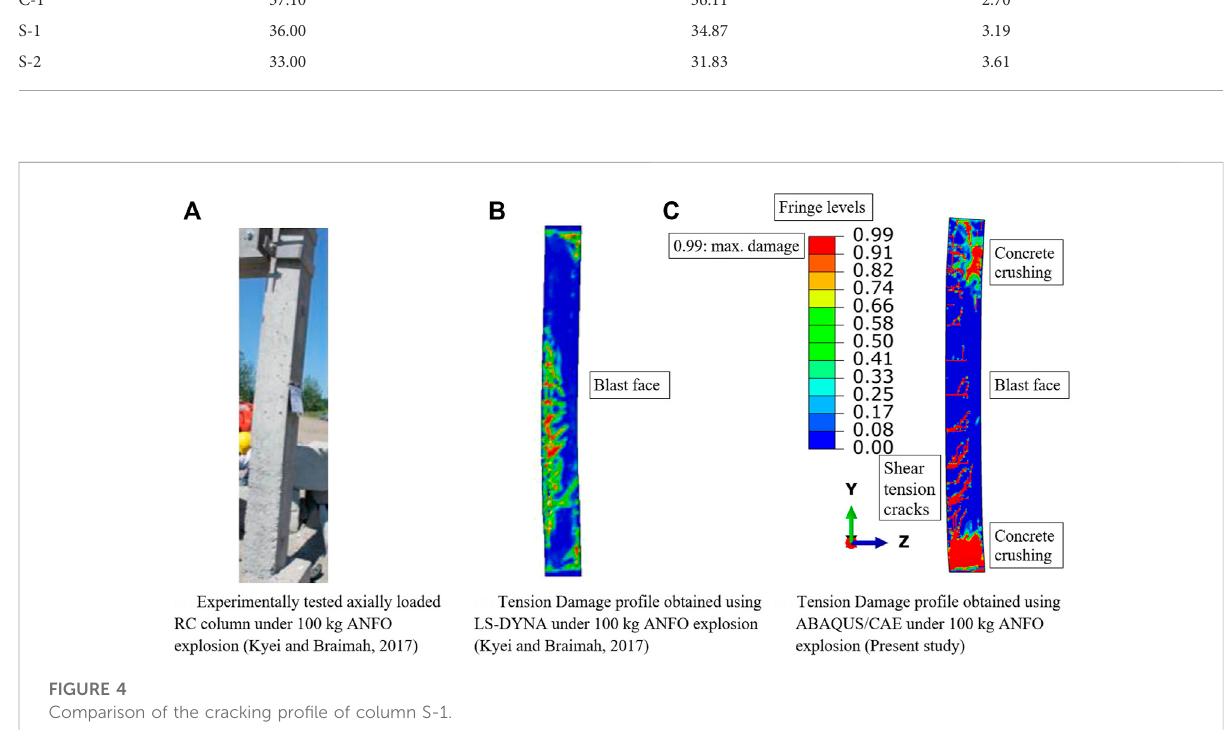
FIGURE 4 Comparison of the cracking pro fi le of column